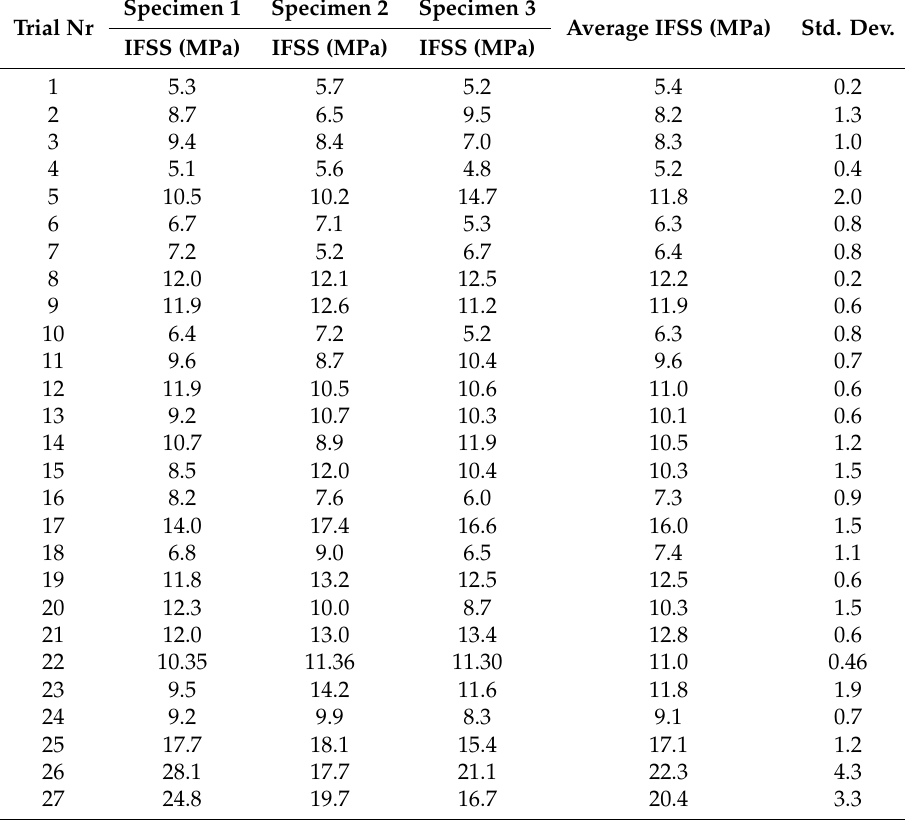
Table 4. Interfacial properties of the composite